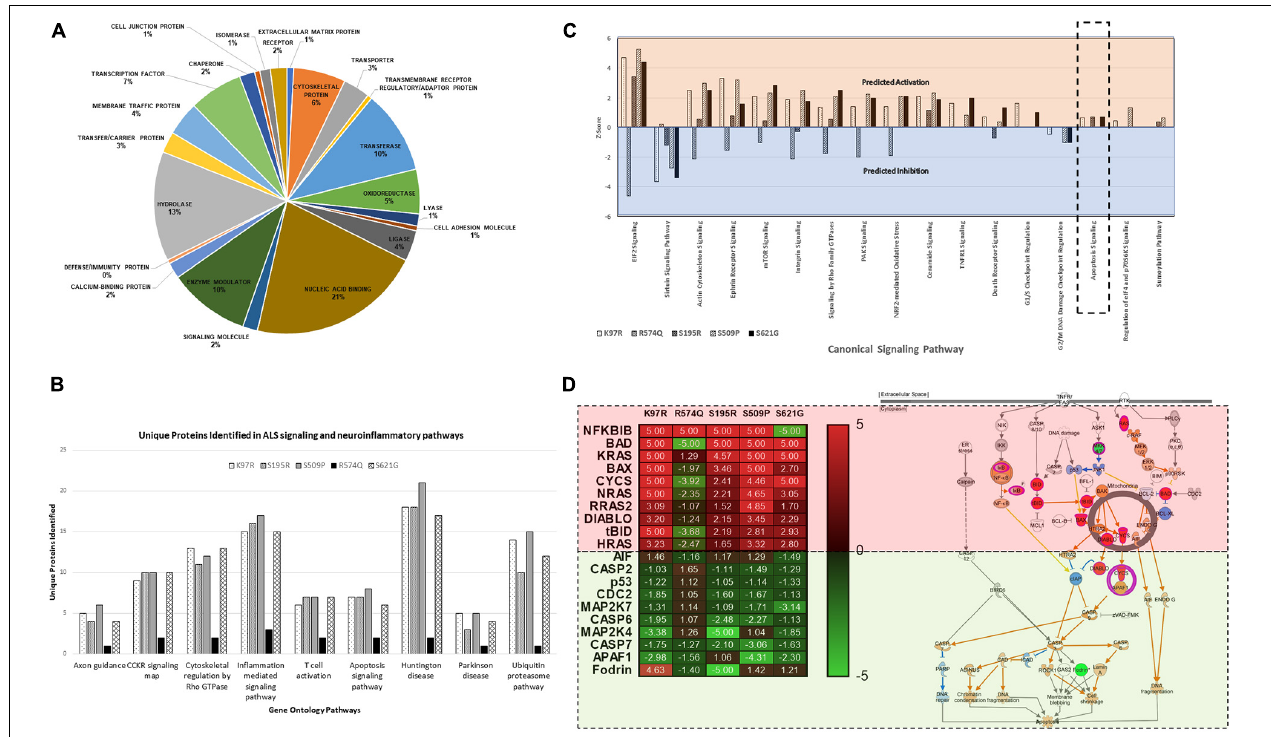
FIGURE 3 | (A) Gene ontology (GO) distribution of the global proteome of HEK293 cells expressing cyclin F variants under the "Protein Class" category demonstrating proteins are classified as having molecular functions: nucleic acid binding, hydrolase, and transferase activity. (B) Selected gene ontology (GO) annotations of unique proteins clustered to selected pathways in neuroinflammation and ALS signalling. (C) Ingenuity pathway analysis (IPA) of the proteomic profile of cyclin F variants predicts activation and inhibition of various canonical cellular pathways. Apoptosis signaling was predicted to be activated in cells expressing cyclin F K97R, S195R, and S621G. Orange and blue annotation refer, respectively, to predicted activation and inhibition as determined by IPA. (D) Heatmap of label-free proteomics of differentially expressed proteins in the apoptosis signaling pathway and IPA prediction of downstream effects (log2 values shown; values shown as 5 and − 5, respectively, indicate detection of the presence and absence of a protein and are not measured values). Red and green annotations refer, respectively, to experimentally measured values. Orange and blue annotations and lines refer, respectively, to predicted activation and inhibition as determined by IPA. Filled and dashed lines, respectively, refer to direct and indirect causal